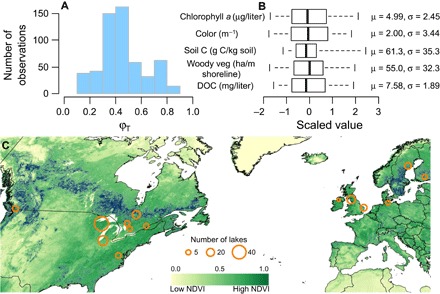
Terrestrial resource (ϕT) use by lake zooplankton.(A) Mean posterior estimates of ϕT for each of the 559 consumer observations. (B) Scaled distributions of key catchment characteristics and unscaled means and SDs. (C) Focal lake regions (n = 14) superimposed on water bodies at a resolution of 1 km and a proxy of vegetation density (NDVI) at a resolution of 0.1° in September 2015 (NASA Earth Observations data repository, http://neo.sci.gsfc.nasa.gov/).